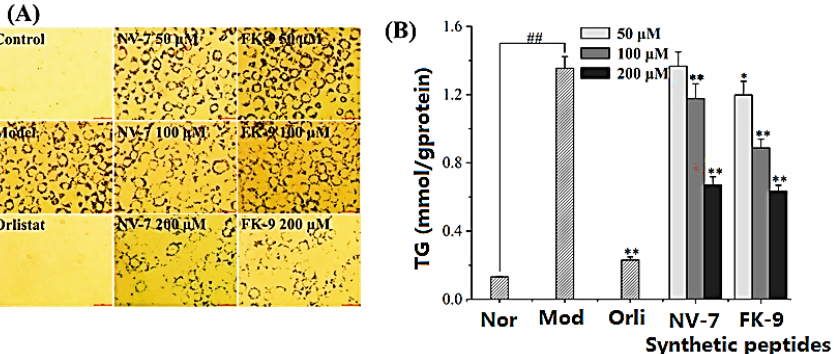
Figure 5. Effect of synthetic peptides on intracellular oil accumulation and triglyceride content of HepG2 ( A ) oil red O staining; ( B ) triglyceride content.